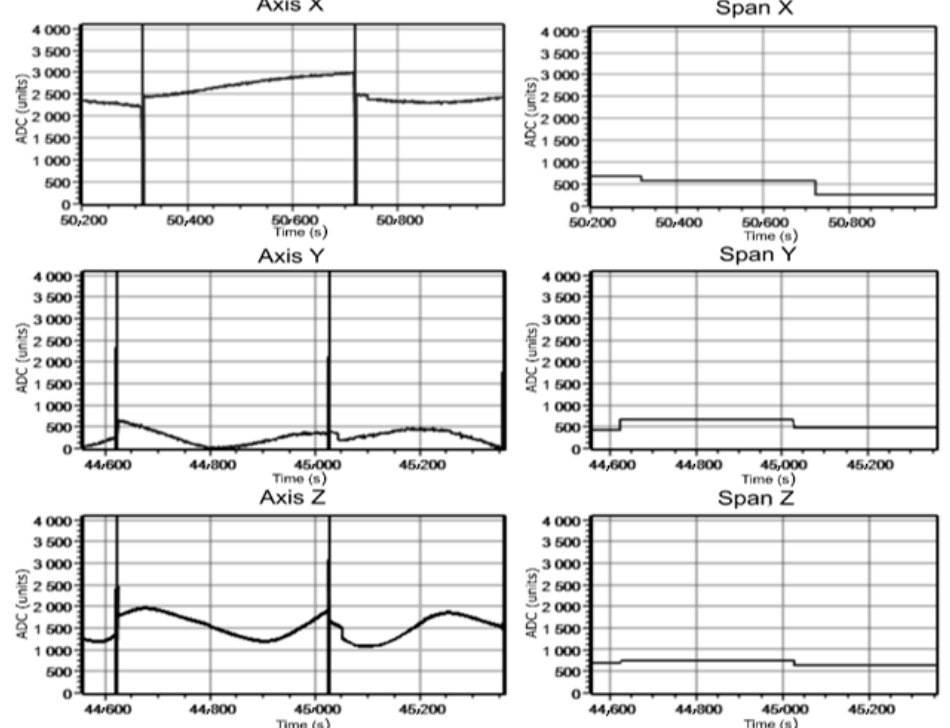
Figure 17. Magnetic induction signals at 65 A current in a cable.